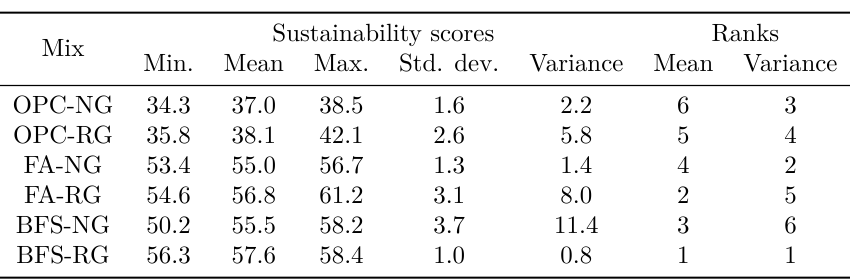
Table 4. Summary statistics of the concrete mixes sustainability performance. Analytical scenario